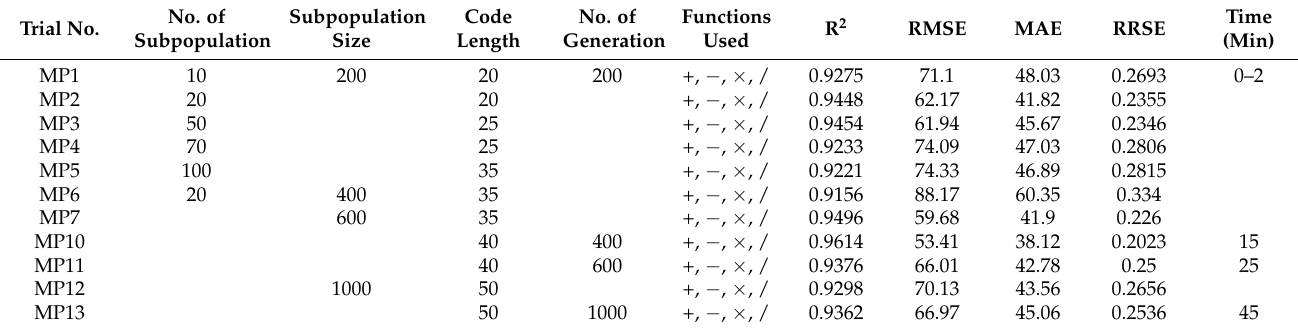
Table 4. MEP optimal